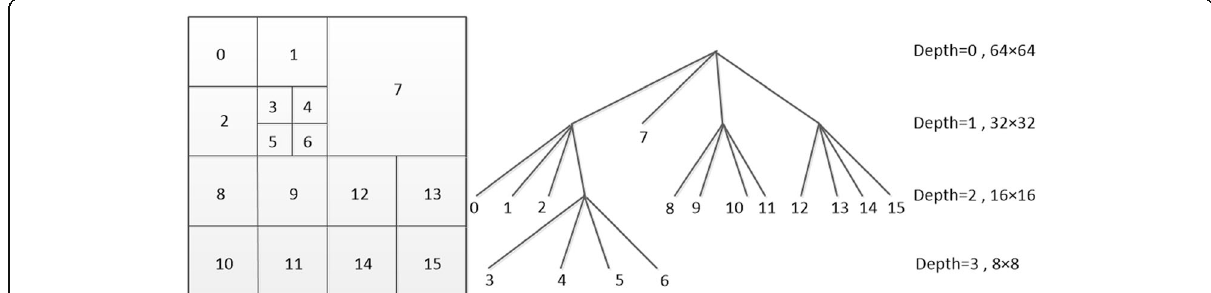
Fig. 1 The quad-tree structure of an LCU partition. To the left is an LCU partition showing CUs sized 64×64 to 8×8. To the right is the corresponding quad-tree structure together with depths and CU sizes